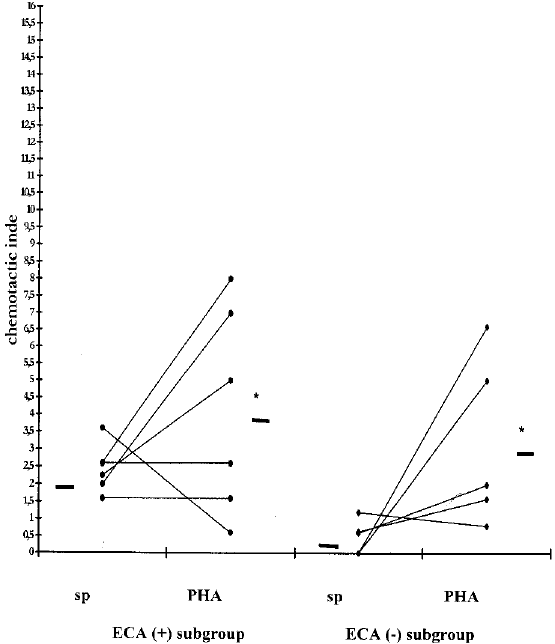
FIG. 1. ECA generation by mononuclear cells (MNC) from atopic asthmatic patients. * P < 0.05 compared with sponta- neous release. Sp.–spontaneous release; Der p I–stimulated release with Der p I. Mean value.